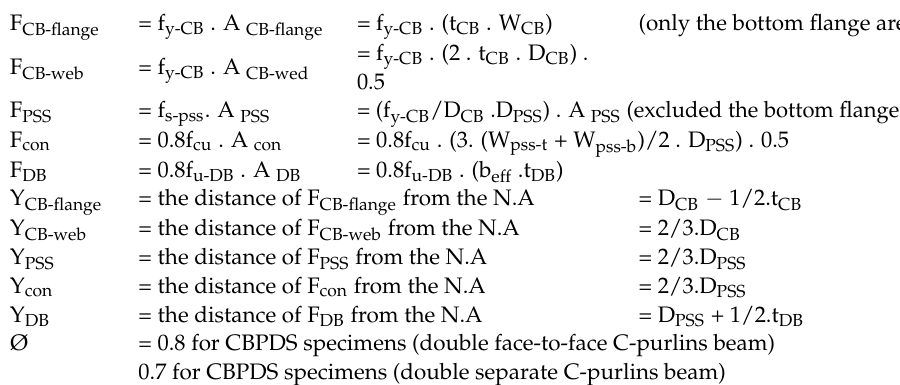
Figure 17. Stress block diagram of CBPDS system.